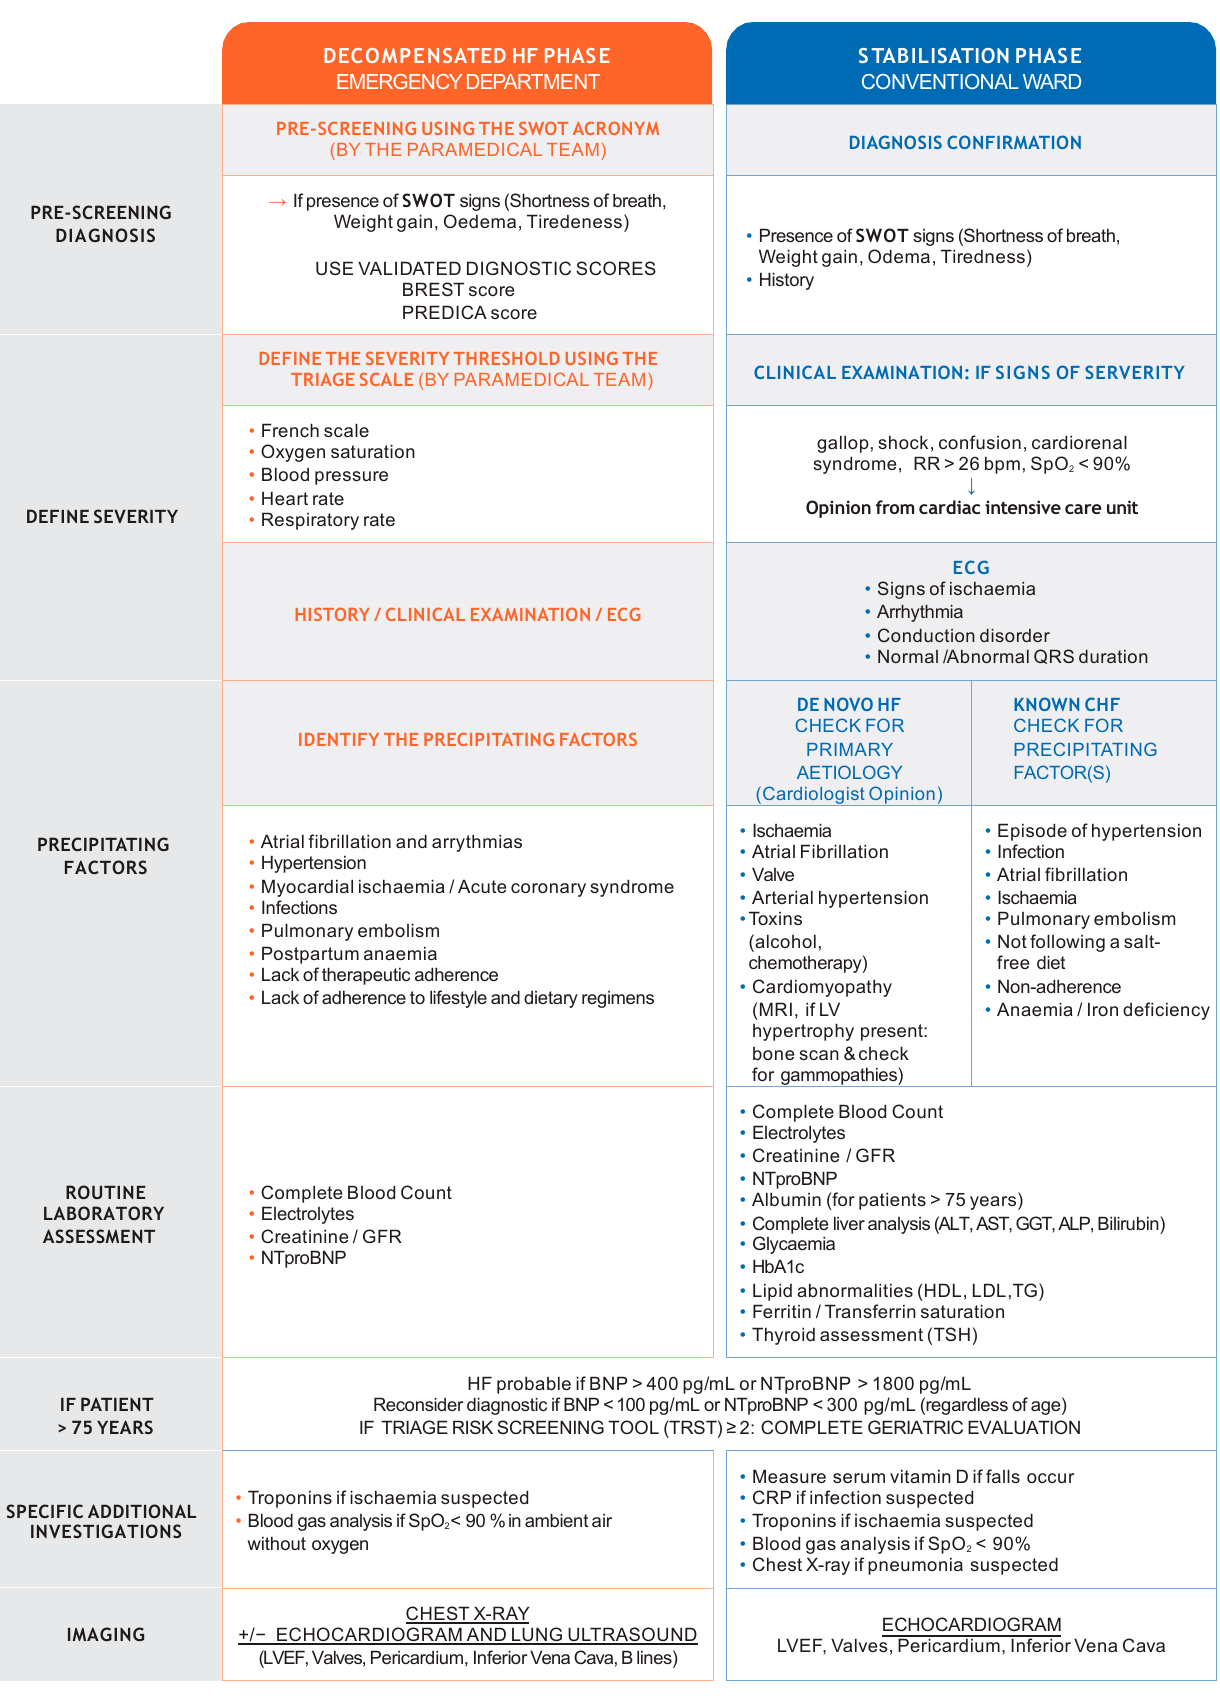
Figure 2. Initial diagnosis. This figure was developed using expert consensus, guidelines and recommendations